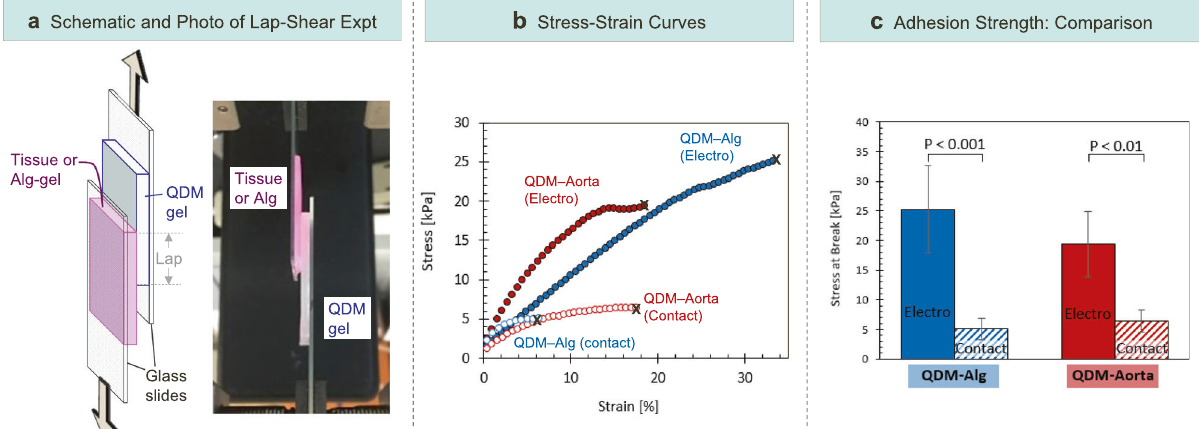
Fig. 6 Adhesion strength measurements using the lap-shear protocol. a Schematic of the lap-shear experiment and a photo of an experiment in progress. Samples are fi rst adhered over a lap region and then af fi xed to glass slides on their reverse sides using cyanoacrylate glue. Tension is then applied to the ends of the slides. b Stress vs. strain curves from lap-shear experiments for two sets of samples: gel-gel (QDM-Alg) and gel-tissue (QDM-aorta). Data are shown for the cases of electroadhesion and contact adhesion (control). The samples delaminate at the end of each curve, marked by an X. The stress at this point is a measure of the adhesion strength. c Adhesion strengths from the curves in ( b ) for the QDM-Alg and QDM-Aorta samples and for the two cases of electro- and contact adhesion. In each category, at least three samples were studied and the averages are plotted. Error bars correspond to standard